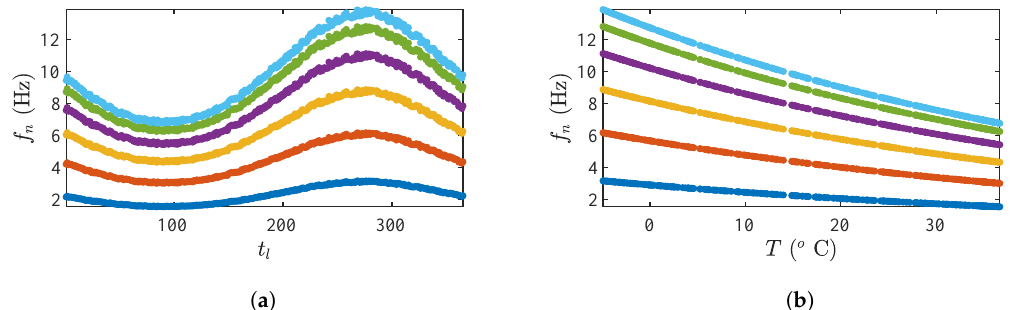
Figure 16. Shear frame: structural vibration modes for the temperature realization of Figure 3: ( a ) f n vs. t l . ( b ) f n vs. T